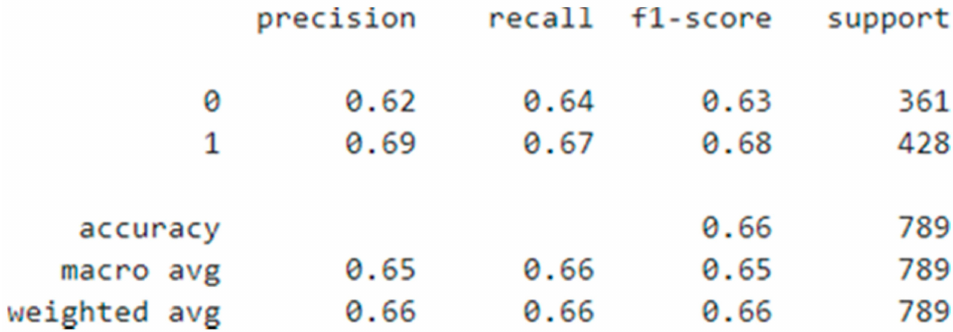
Figure 7. Logistic Regression Classification